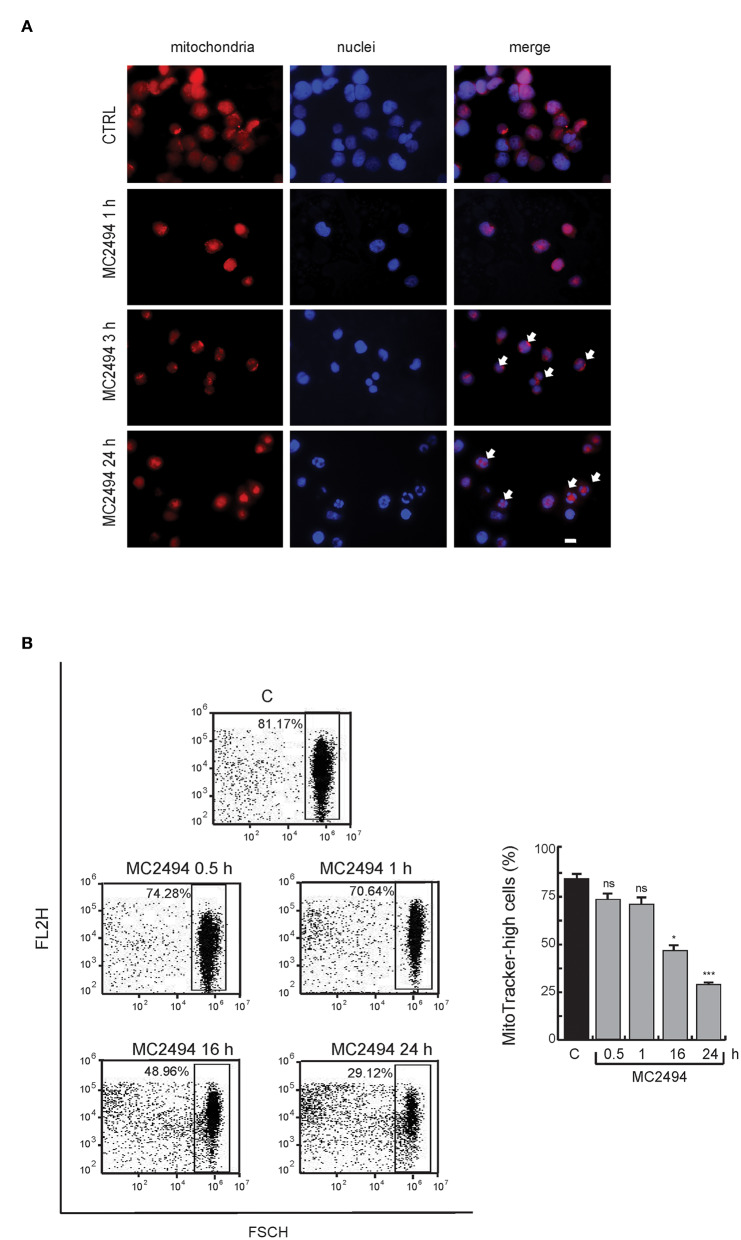
(A) Immunofluorescence analysis. MitoTracker Orange staining for cells untreated or treated for the indicated times with MC2494. Images representative of 3 different experiments captured by immunofluorescence microscope show staining of mitochondria (red) and nuclei (blue). Bar, 10 μM. Arrows denote the presence of fragmented mitochondria and nuclei after 3 and 16 h of MC2494 treatment. (B) FACS analysis of mitochondrial content. FACS dot plot (left panel) shows a decrease in MitoTracker Orange signal upon MC2494 treatment. Histogram showing data obtained (right panel). Values are mean ± standard deviation (SD) of biological triplicates. ***p ≤ 0.001, *p ≤ 0.05, nsp > 0.05 vs. control cells.